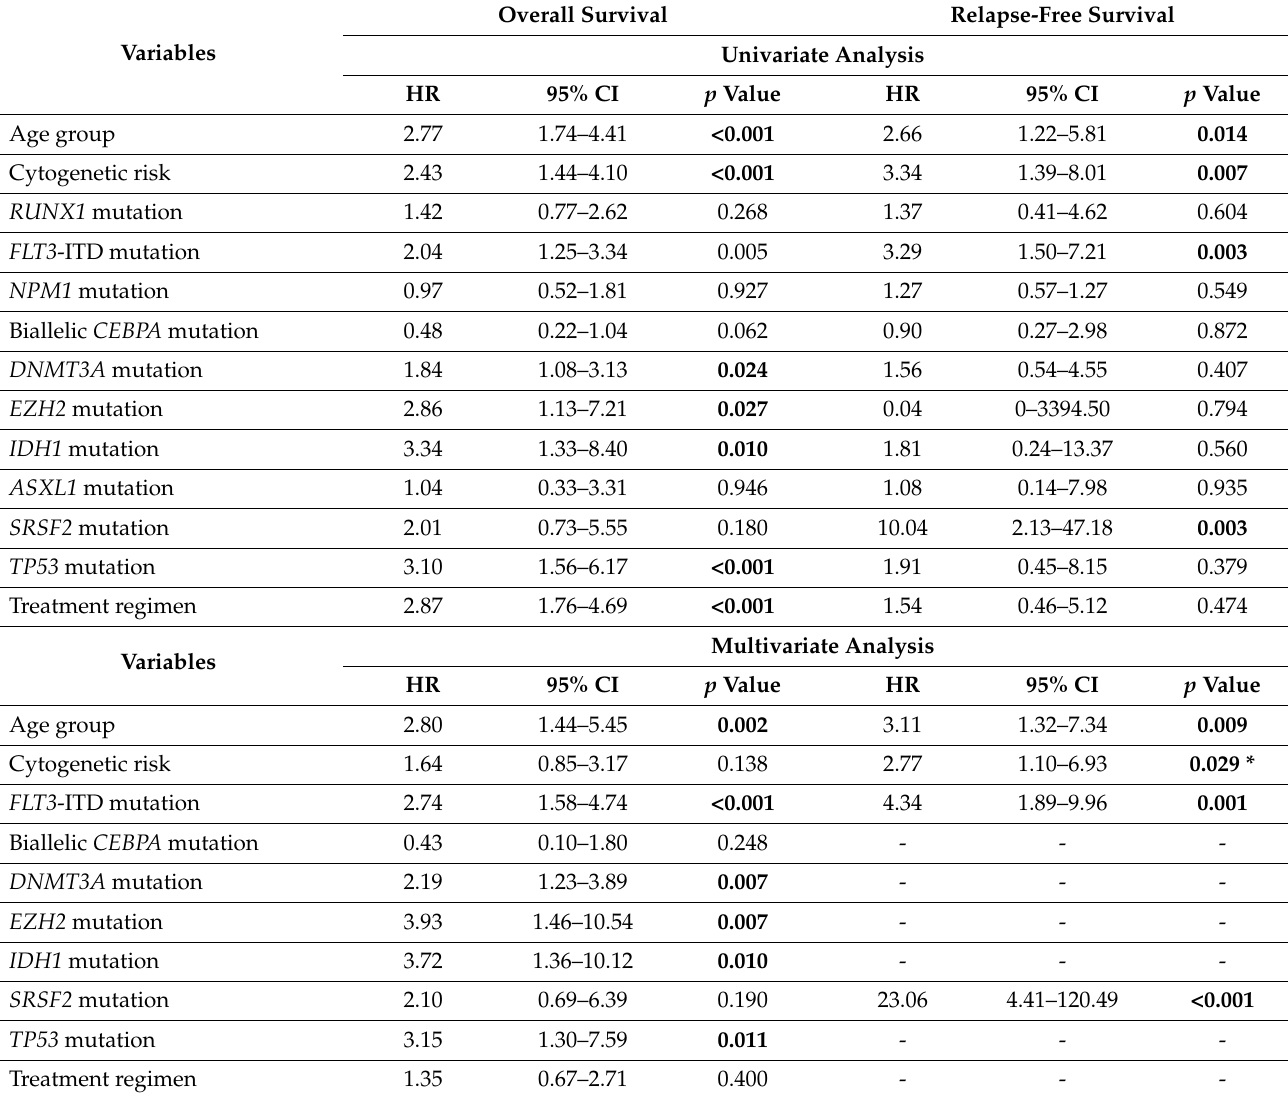
Table 2. Factors associated with overall survival and relapse-free